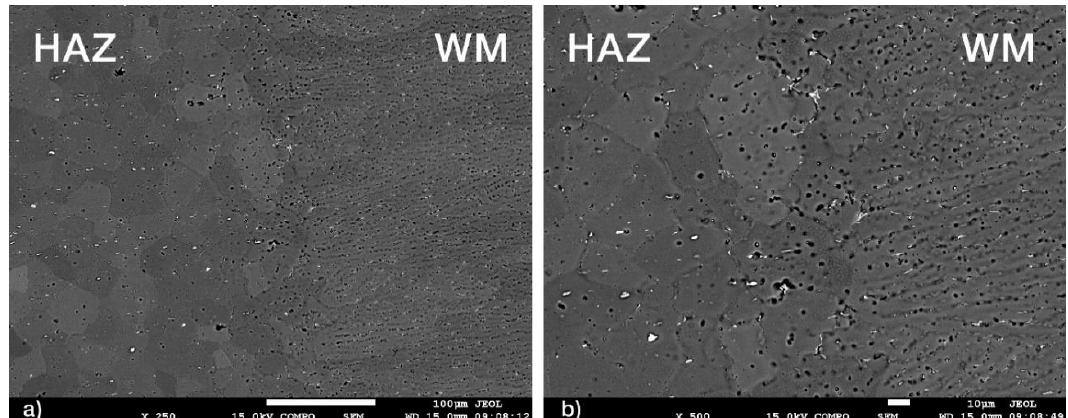
Figure 6. Scanning electron microscope (SEM) images of ( a ) HAZ–WM; ( b ) a higher magnification of part of the region shown in ( a ).